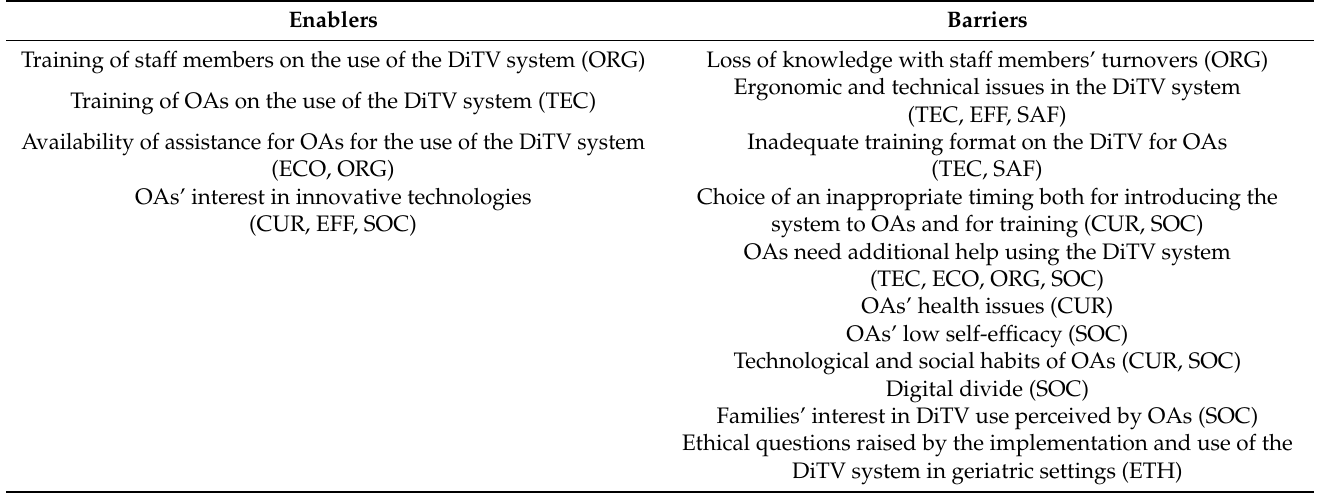
Table 5. Summary of enablers and barriers to the DiTV system use and associated HTA dimensions. Enablers Barriers Loss of knowledge with staff members’ turnovers